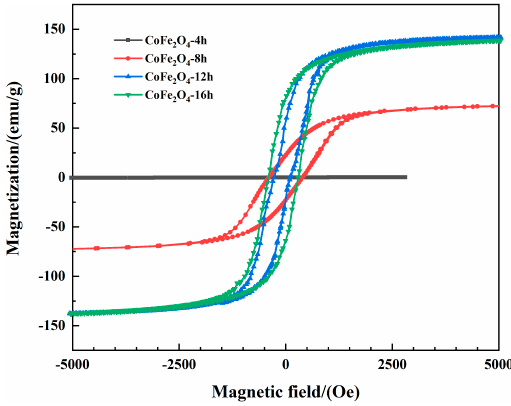
Figure 4. Hysteresis loops of CoFe 2 O 4 measured at room temperature.